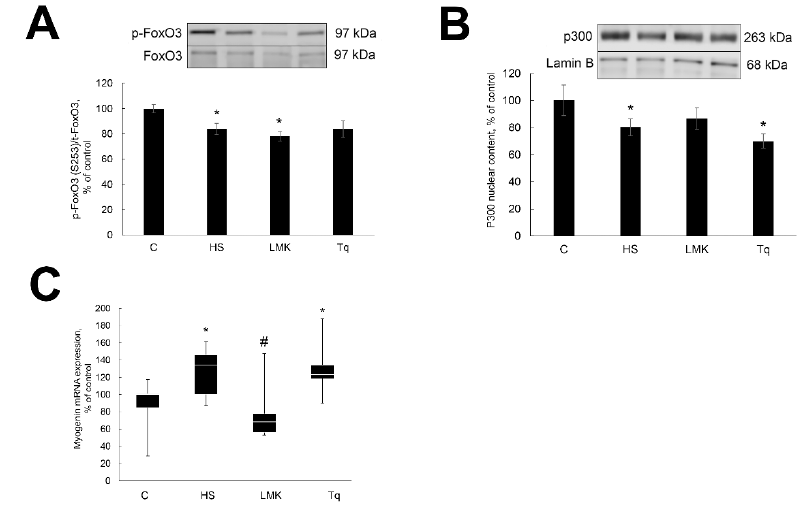
Figure 4. Evaluation of phosphorylated FoxO3 content ( A ), P300 nuclear content ( B ) and MYOG mRNA expression ( C ) in soleus muscles of nontreated control rats ( C ), rats after 3 days of unloading (HS), 3 days HS with LMK-265 inhibitor (HSLMK) or HS with Tq inhibitor (HSTq). Values are normalized to the levels of total FoxO3 protein ( A ) or Lamin B1 ( B ) in each sample. Levels of MYOG mRNA were normalized to the levels of GAPDH in each sample ( C ). n = 8. * indicates a significant di ff erence